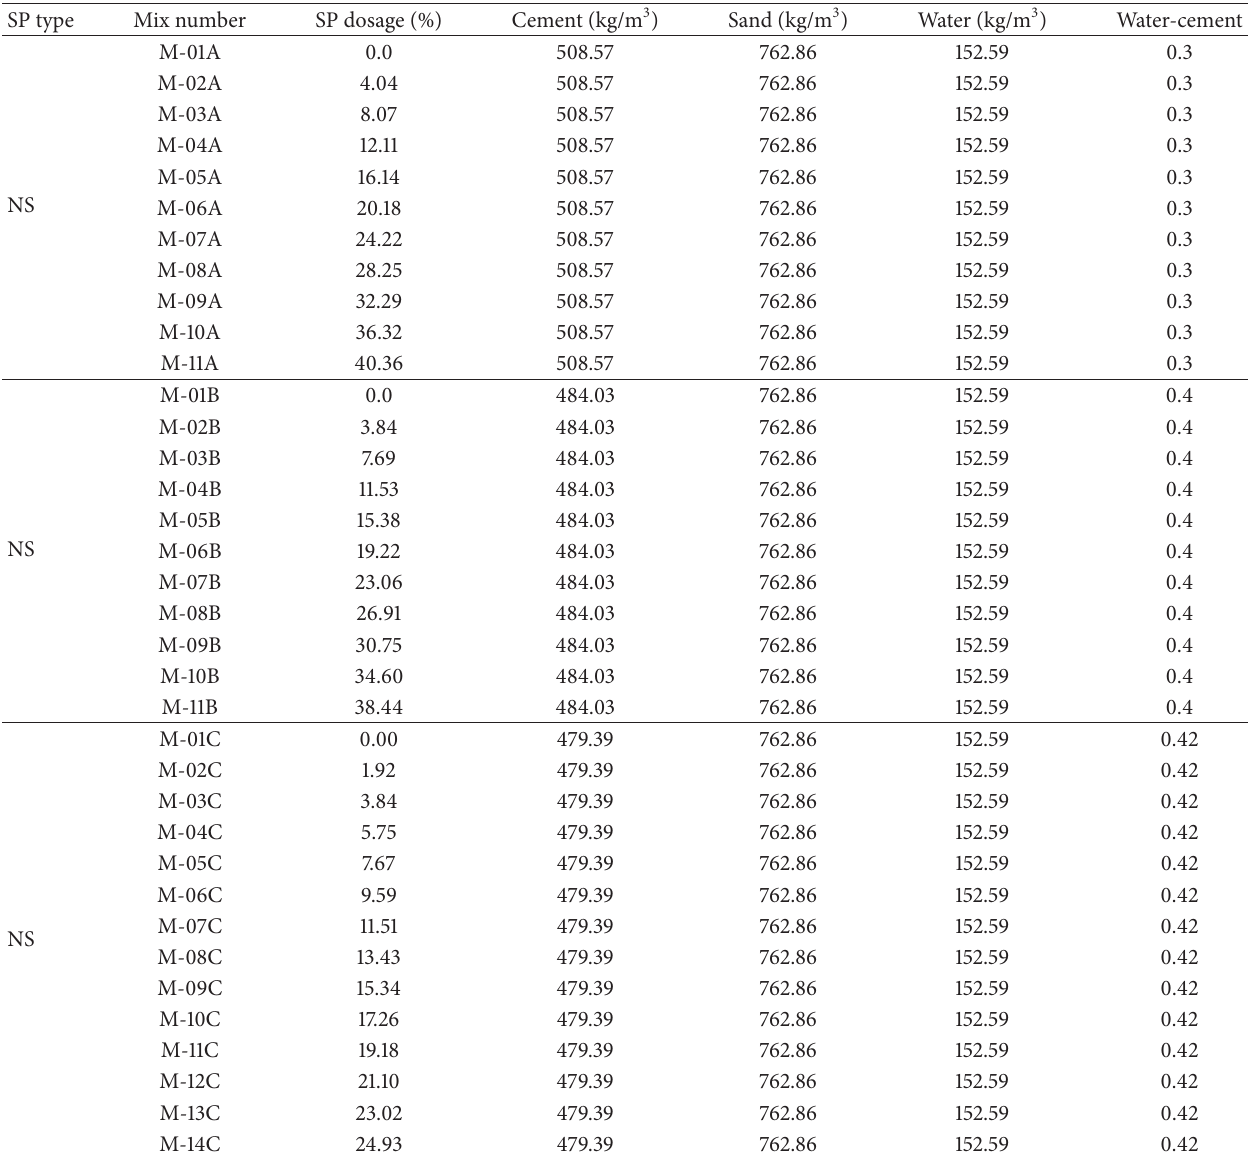
Table 2: Mix proportions for the compatibility